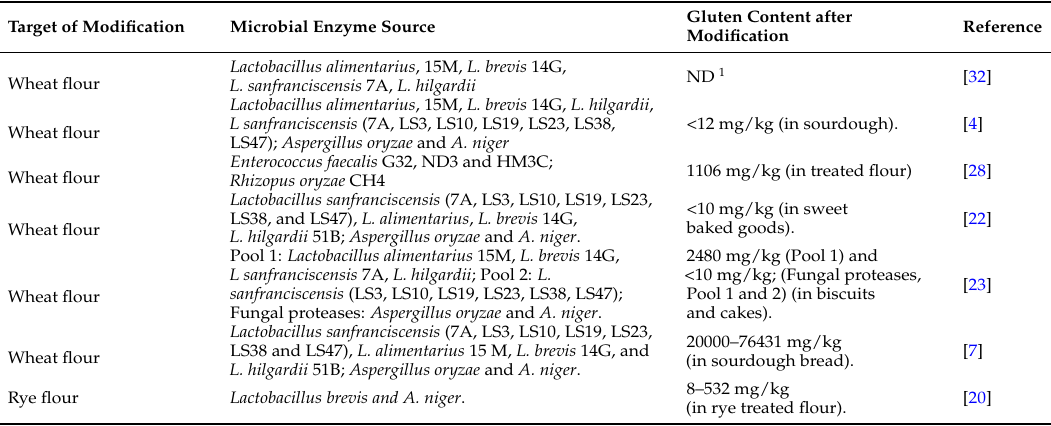
Table 1. Summary of studies on gluten modification by microbial proteases for baked product